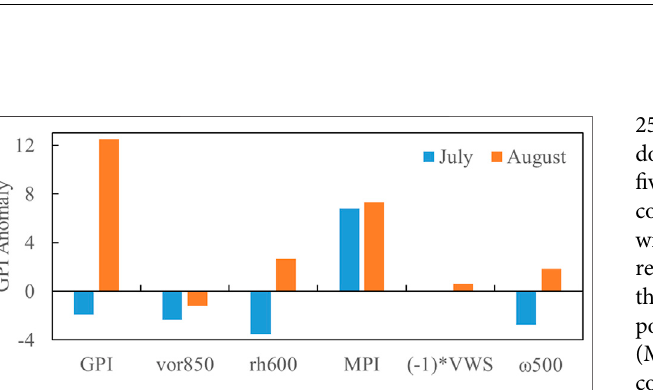
FIGURE 3 | (A) Total GPI anomaly in August 2020 and the respective contribution from the individual variables for (B) 850-hPa absolute vorticity, (C) 600-hPa relativehumidity, (D) maximumpotentialintensity, (E) VWS,and (F) 500-hPaverticalpressurevelocity.Thebluedashedbox(5-25 ° N,110 ° E-180 ° )representsthemainTC genesis region over WNP. The green dots in (A) represent the locations of TC geneses.